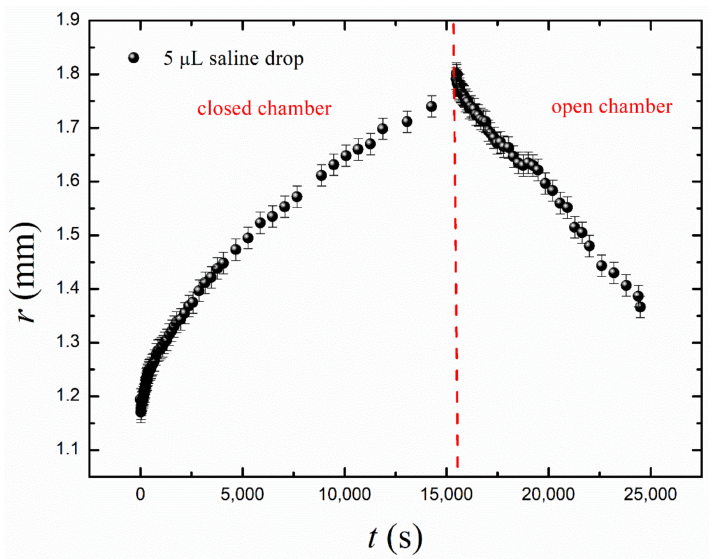
Figure 6. Growth and decay of a 5 µ L saline drop on a floating PDMS membrane due to osmosis and